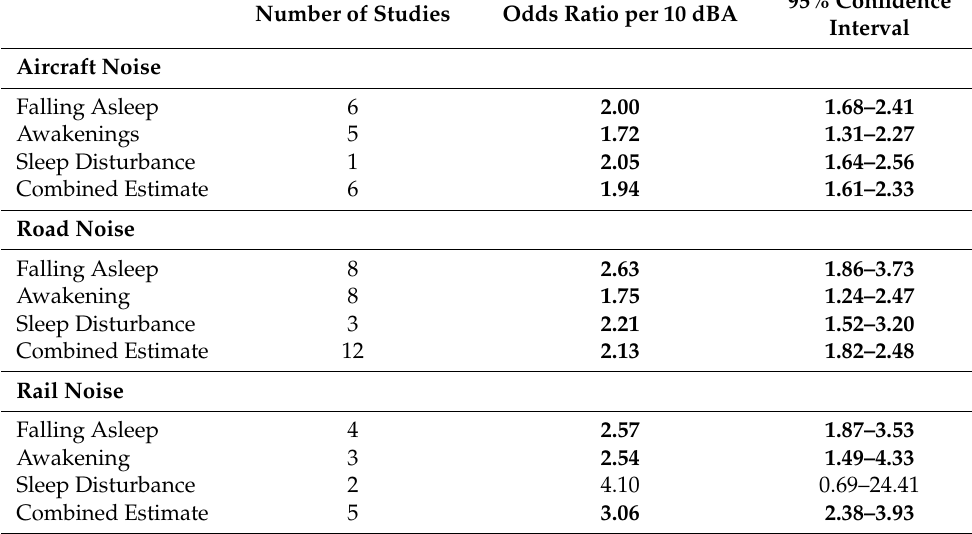
Table 5. Unadjusted Odds Ratio for the percent highly sleep disturbed for road, rail, and aircraft noise for questions on falling asleep, awakenings, and sleep disturbance for a 10 dBA increase in L night . L night was treated as a continuous variable from 40 to 65 dBA. Results are for questions that asked how noise affects sleep. Bold font reflects statistically significant results at p < 0.05. The combined estimate is based on all sleep questions. The number of subjects contributing to the analyses can be found in Tables 2–4.